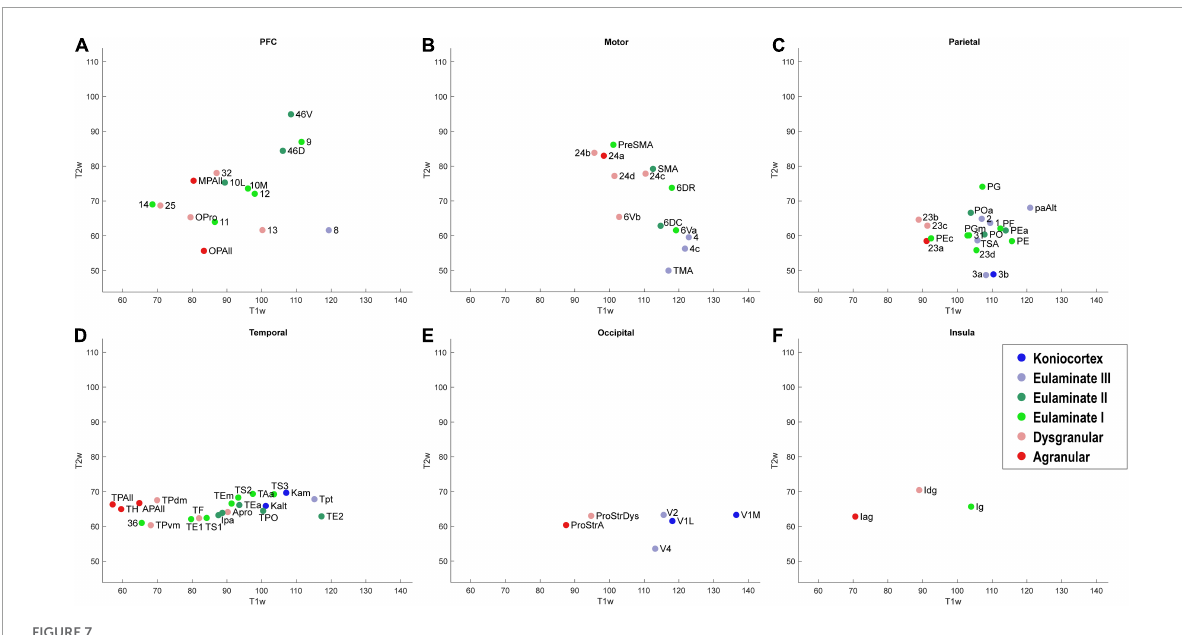
FIGURE7 Scatter plot of T1w and T2w MRI data from 78 cortical areas, divided by system. (A) Prefrontal cortex, (B) Motor cortex, (C) Parietal cortex, (D) Temporal cortex, (E) Occipital cortex, (F) Insular cortex. Due to overlap of data points, area labels were omitted from some of the points for clarity.